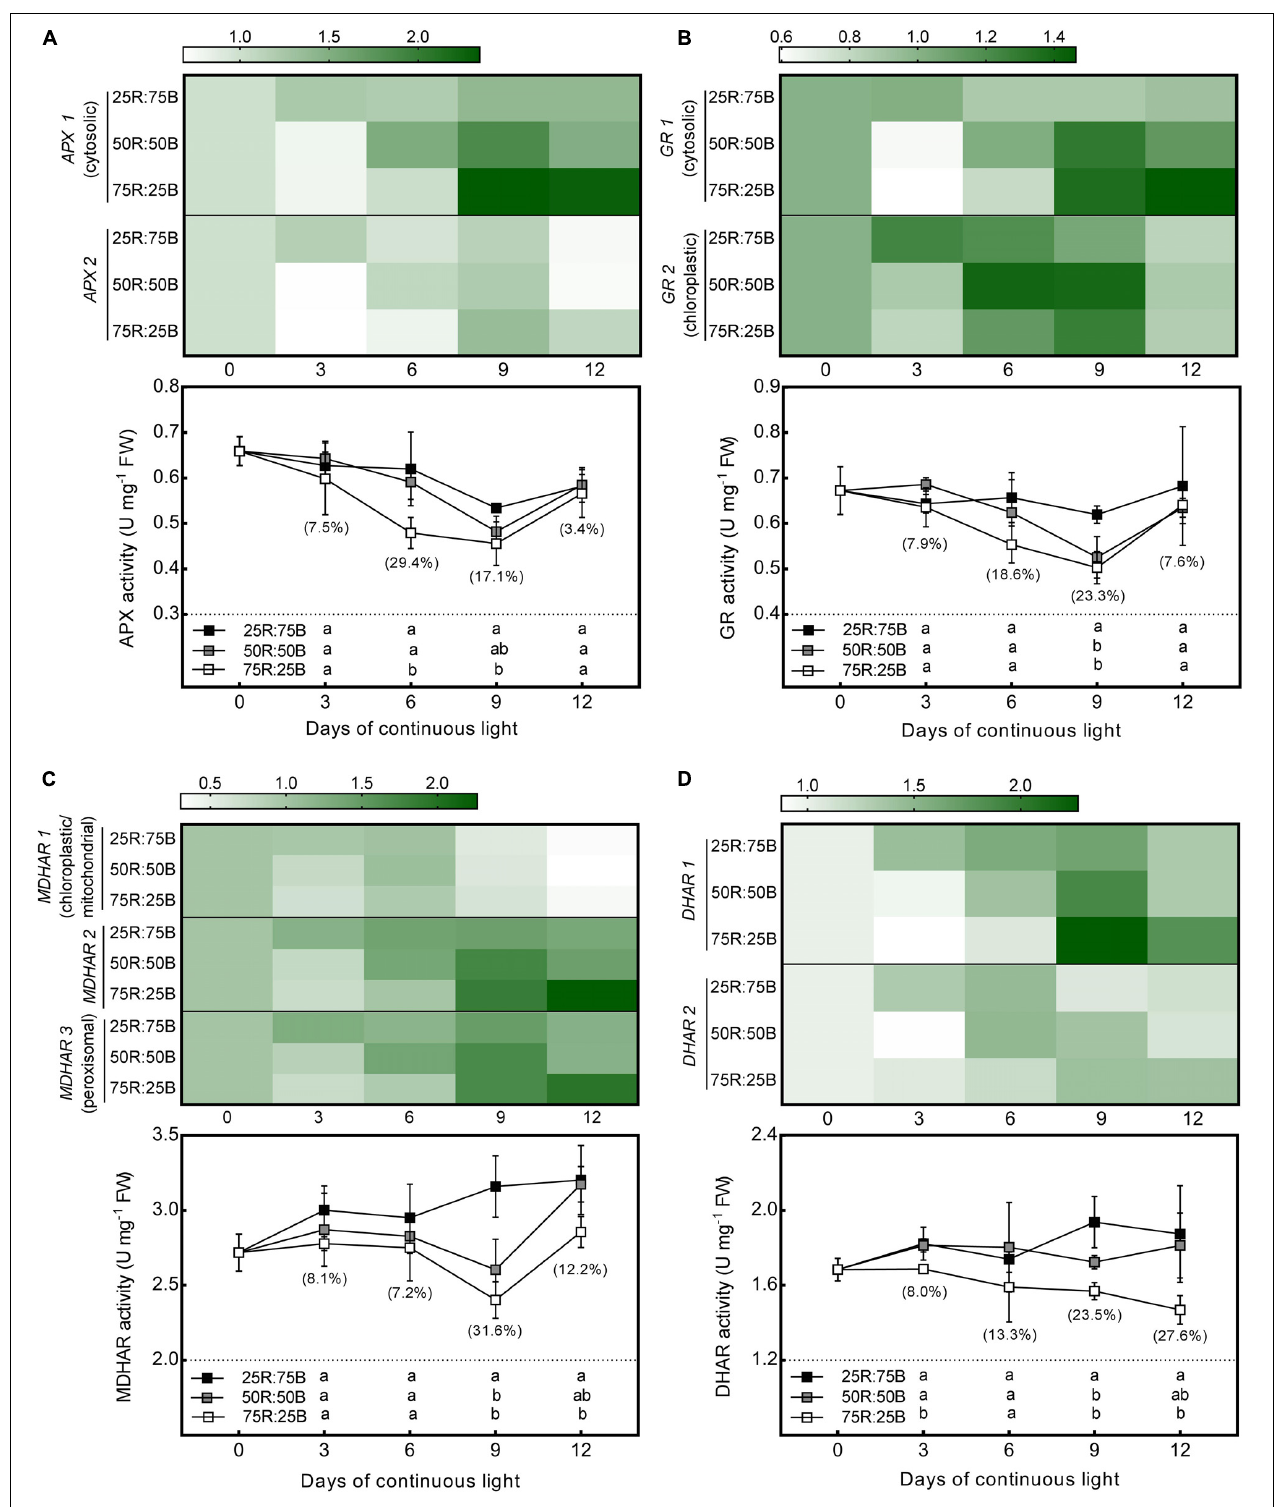
FIGURE 4 | Effects of the red:blue light ratio on the transcript level and activity of APX (A) , GR (B) , MDHAR (C) , DHAR (D) in lettuce leaves under continuous light (200 µ mol · m – 2 · s – 1 ). Transcript level data are the mean values of three replications. Enzyme activity data are the mean values ± SD of four replications. Different letters indicate significant differences between different red:blue light ratio treatments at p < 0.05 according to Tukey test. Data in brackets were the increasing rate of the maximum value to the minimum value on the same day.